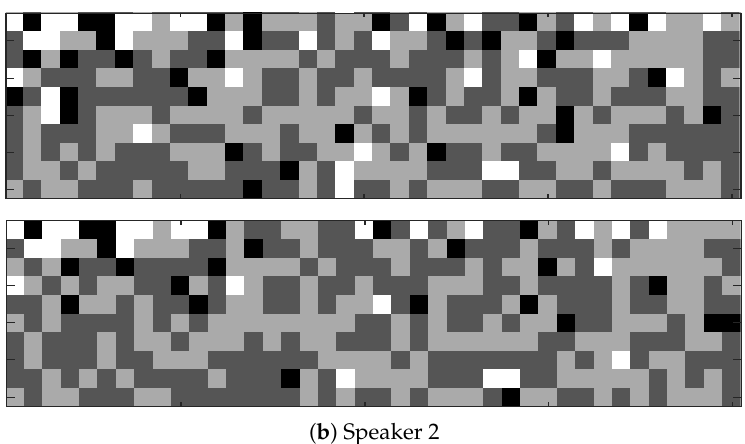
Figure 2. Examples of 400-dimensional RBM vectors. The figure shows two pairs of RBM vectors from the test audios. Each pair belong to the same speaker. We rearrange the RBM vectors in the form 10 × 40 for the convenience of visualization. The ordering of the RBM vector is the same for